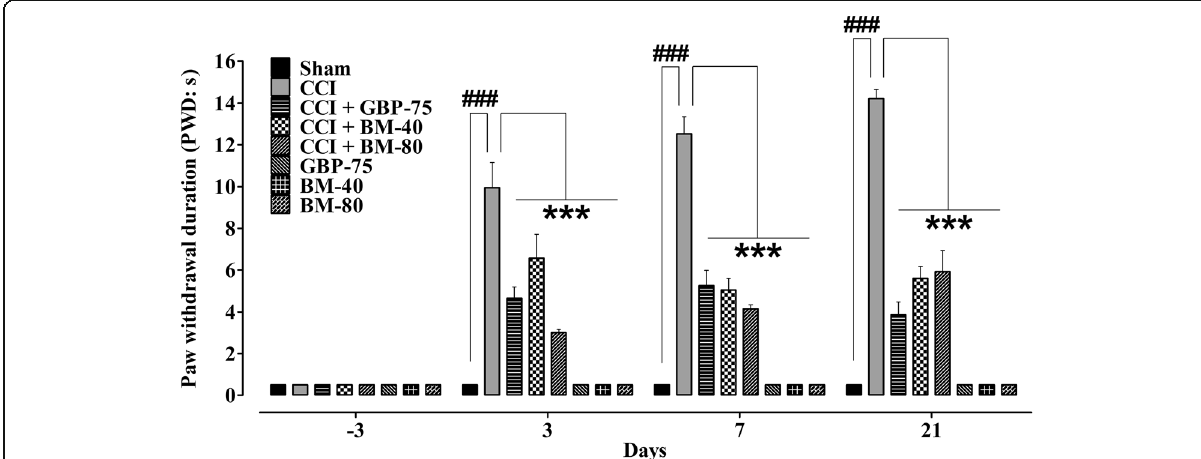
Fig. 6 Effect of Bacopa monnieri methanolic extract (BM-40 and BM-80) and gabapentin (GBP-75) on the maintenance of chronic constriction injury (CCI) induced cold allodynia (increased paw withdrawal duration to a drop of acetone; PWD in s). Values expressed as mean ± S.E.M. ### P < 0.001 compared to sham-operated animals, *** P < 0.001 compared to CCI-operated untreated animals, two-way repeated measures ANOVA followed by post hoc Bonferroni analysis. n = 6 rats per